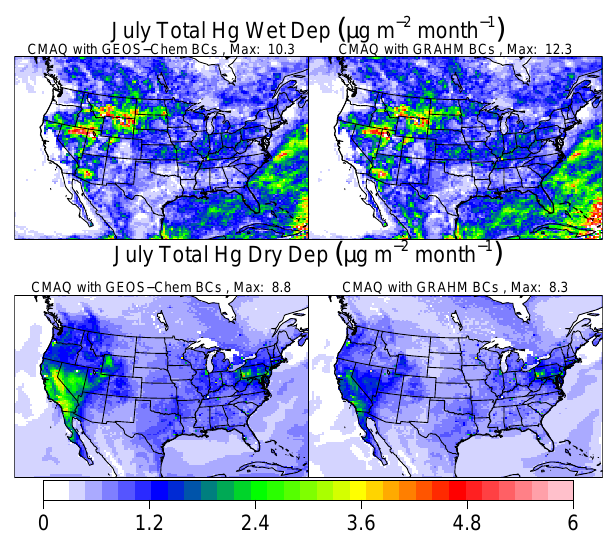
Fig. 2. CMAQ simulated mercury wet and dry deposition us- ing boundary conditions derived from GEOS-Chem and GRAHM global models, with 2001 meteorological inputs. Circles on wet de- position plots indicate locations of Mercury Deposition Network wet deposition observations. Dry deposition includes only divalent forms of